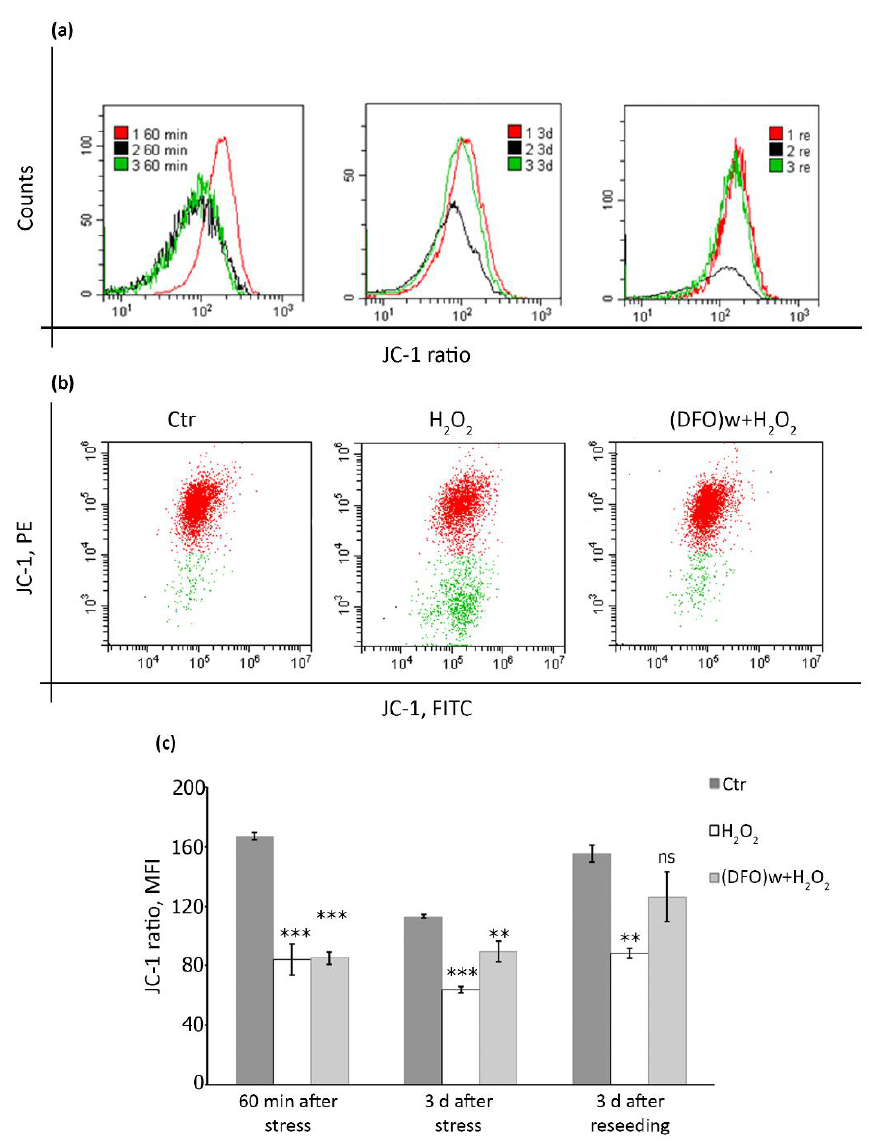
Figure 6. Stress-induced alterations of mitochondrial membrane potential in hMESCs. ( a ) Histograms of JC-1 ratio assayed by FACS; cells were analyzed directly after stress (left panel), three days after (middle panel) and after reseeding (right panel); 1–untreated cells (Ctr), 2–cells exposed to 200 µM of H 2 O 2 for 1 h, 3–cells pretreated with 1mM of DFO for 2 h, washed and exposed to 200 µM of H 2 O 2 for 1 h; ( b ) representative dot plots illustrate the dynamics of JC-1 forms’ redistribution (3 d after the treatments): aggregative (red) and monomeric (green), which depends on the mitochondrial membrane potential; ( c ) the same data as in ( a ), depicted graphically; data are shown as Mean ± SD, n = 3; *** p ˂ 0.005, ** p < 0.01.